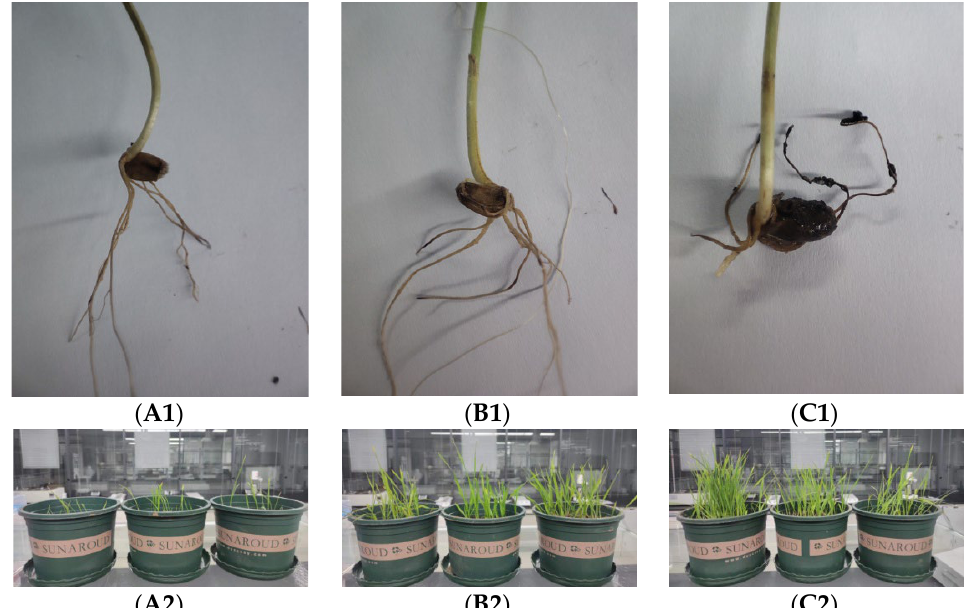
Figure 7. Biocontrol efficiency of JK-25 CF on common root rot caused by B. sorokiniana . In all experimental groups, the wheat was pre-inoculated with B. sorokiniana during growth. ( A1 , A2 ) Watering with sterile water only during growth; ( B1 , B2 ) irrigation with 50% carbendazim during growth; ( C1 , C2 ) irrigation with JK-25 CF during growth. Table 3. Biocontrol efficacy of JK-25 on common root rot.